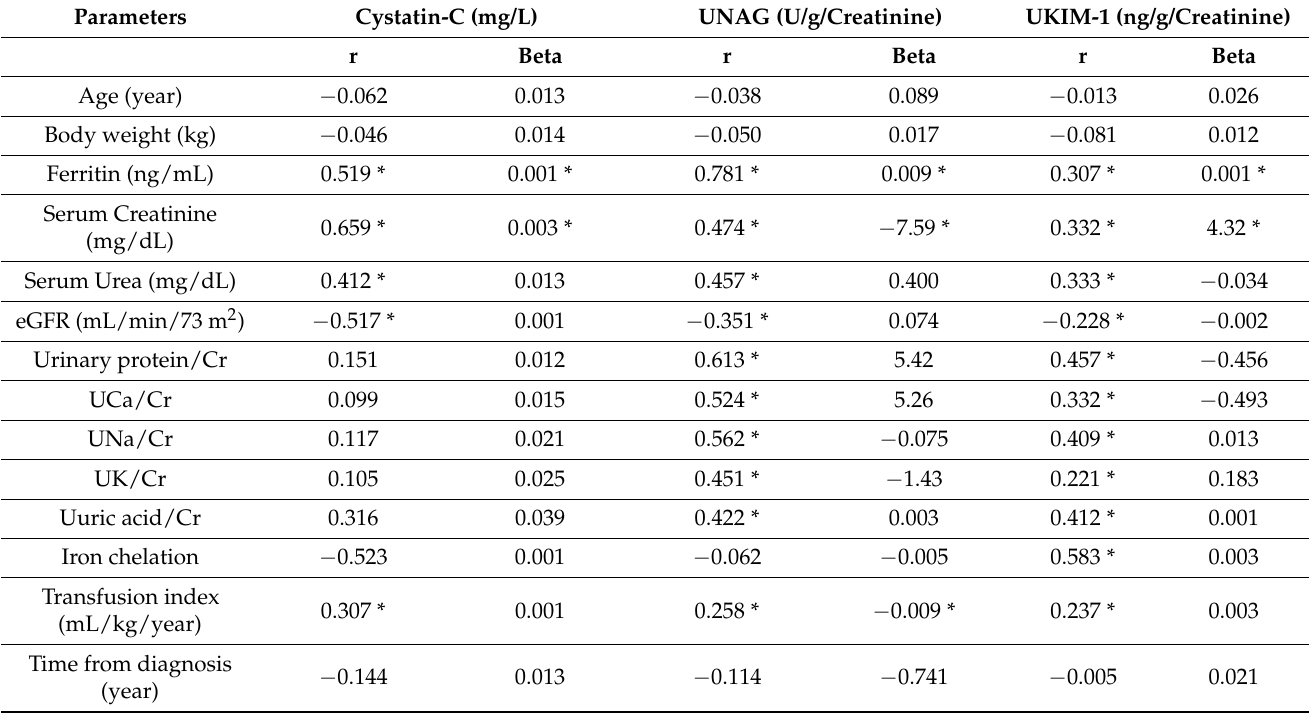
Table 4. Univariate correlation and multi-linear regression between serum Cytatin-C, UNAG, or UKIM-1 and other parameters among studied beta-TM